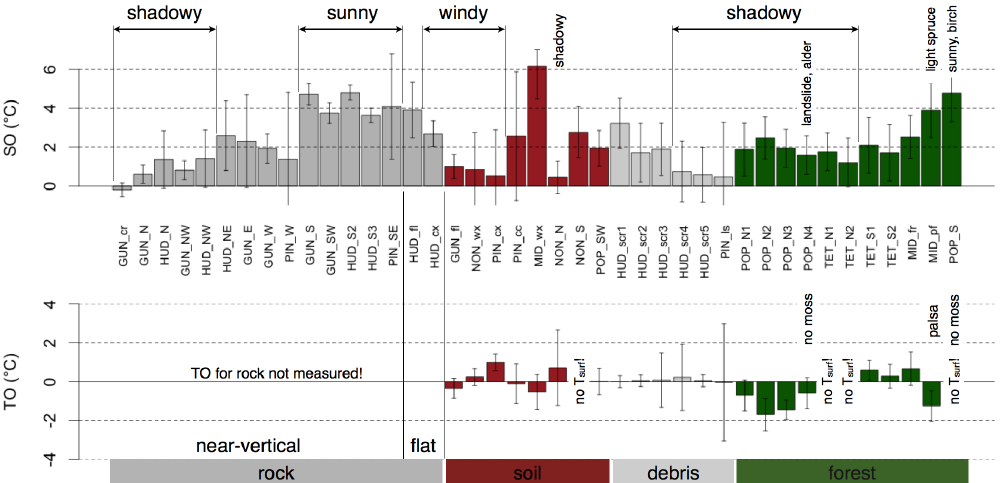
Figure 4. Surface and thermal offsets grouped by different surface types (substrate and vegetation) and with indication of microtopographic situation and forest